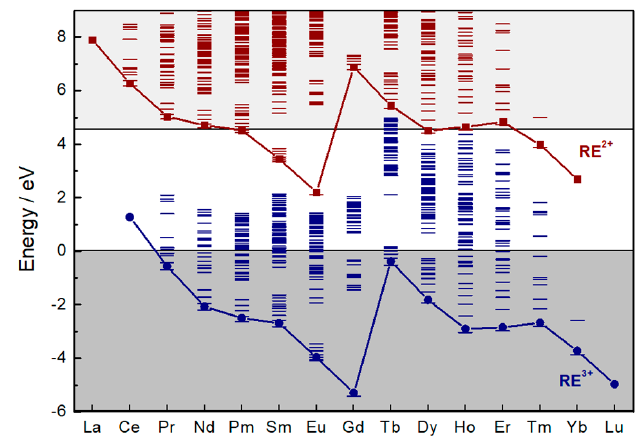
Figure 8. Host-referred 4 f -electron binding energy curves and excited state energies of RE 2 + and RE 3 + Figure 8. Host ‐ referred 4 f ‐ electron binding energy curves and excited state energies of RE 2+ and RE 3+ ions in SrS. Reproduced from [156] with permission from The Royal Society of ions in SrS. Reproduced from [156] with permission from The Royal Society of Chemistry.